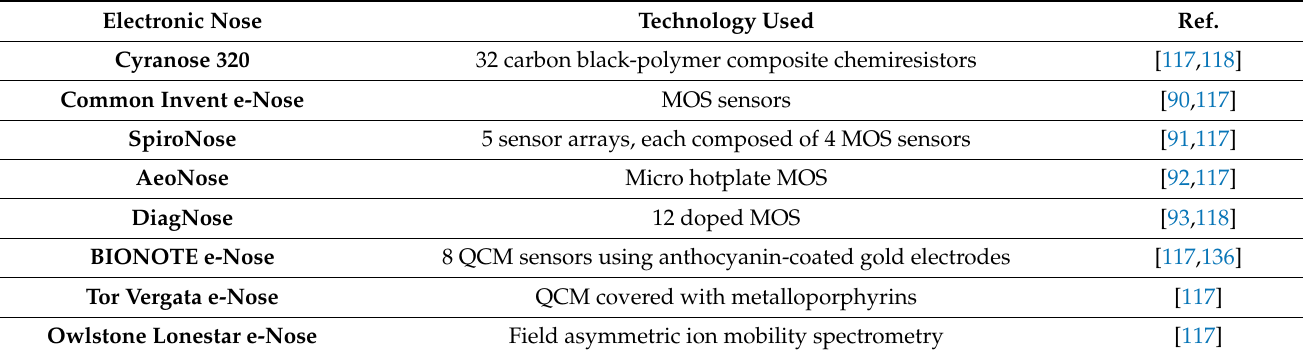
Table 3. Branded e-Noses and type of technology used in each